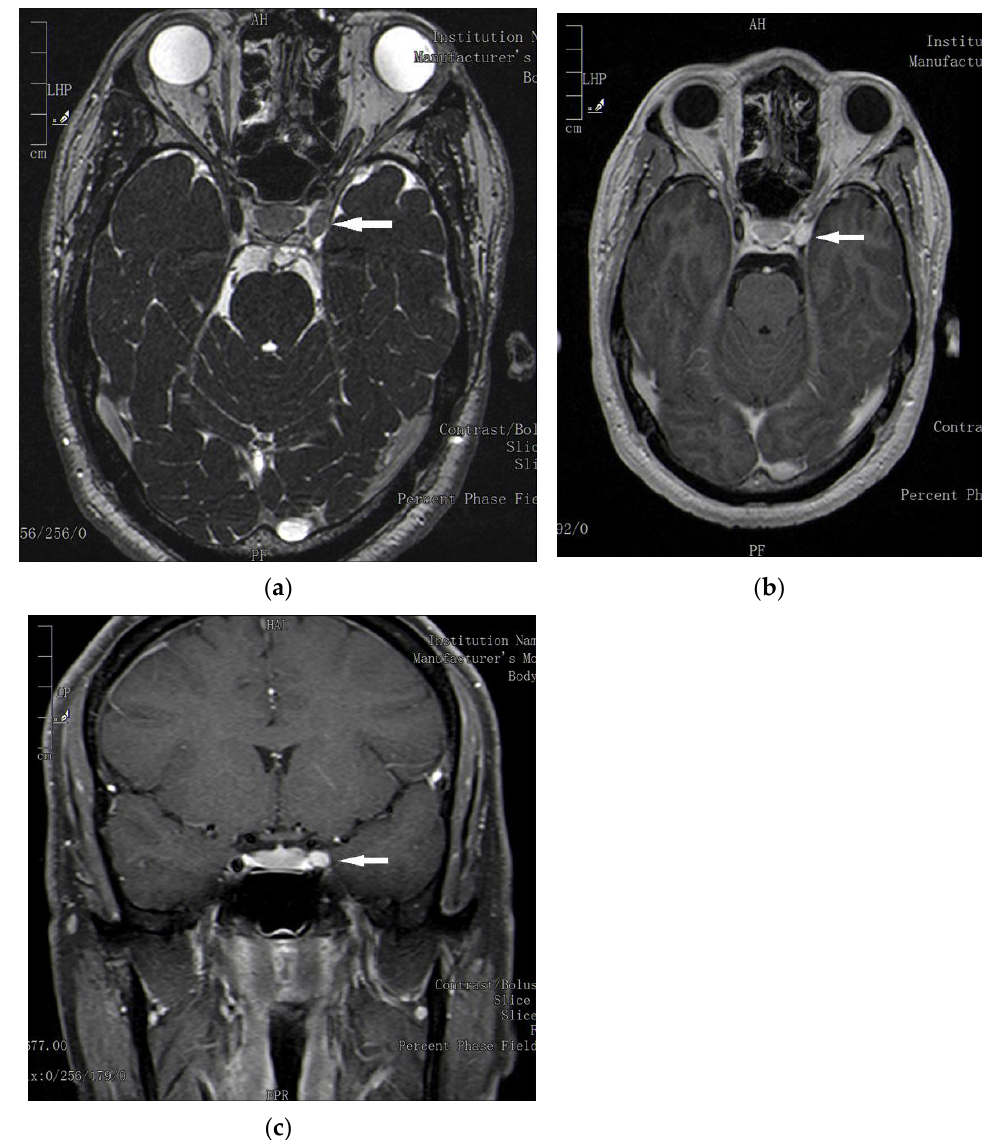
Figure 2. Brain magnetic resonance imaging demonstrating (see respectively white arrow) a possible oculomotor nerve schwannoma in the left sinus cavernous, highly enhanced by gadolinium (Gad). ( a ): T2-weighted axial magnetic resonance imaging (MRI) brain without Gad. ( b ): T1-weighted axial brain MRI with Gad. ( c ): T1-weighted coronal brain MRI with Gad.